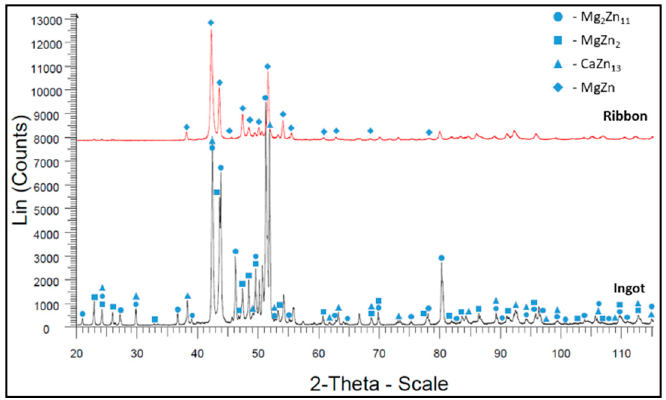
Figure 4. X-ray di ff raction results for Mg 72 Zn 24 Ca 4 alloy samples. Figure 4. X-ray diffraction results for Mg 72 Zn 24 Ca 4 alloy samples.